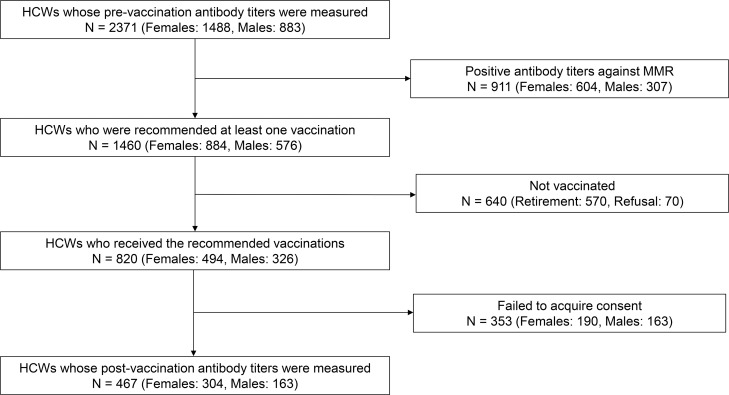
Flow chart detailing subject selection in the vaccination implementation program and this study.